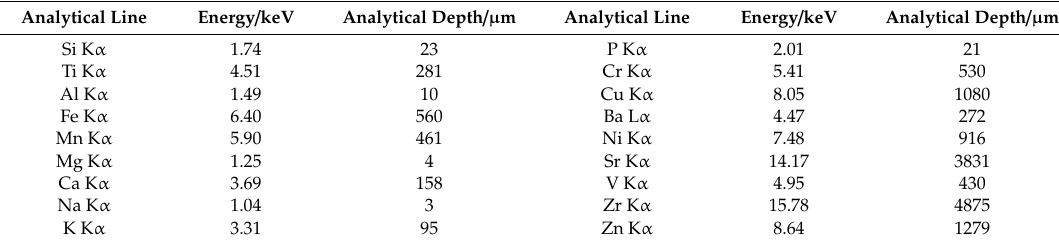
Table 4. Analytical depths of the fluorescent X-rays in the fused glass